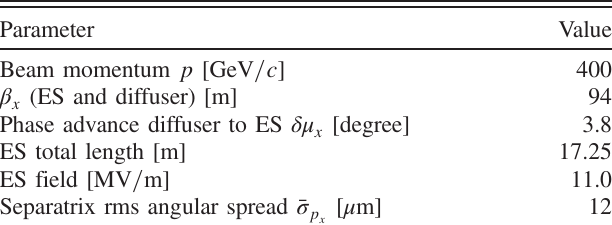
TABLE III. Parameters assumed for diffuser